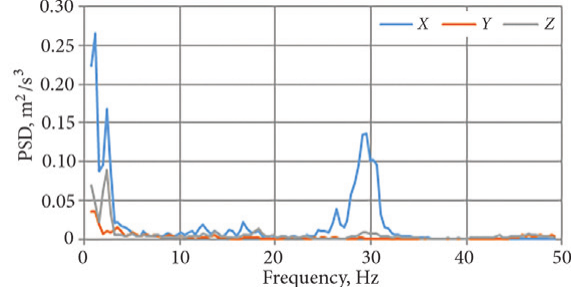
Figure 4. Power Spectral